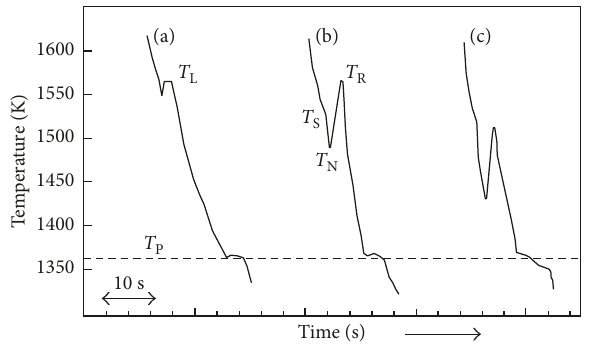
Figure 2: Measured cooling curves of three Cu-15 wt.% Fe samples: (a) ∆ T 35K; (b) ∆ T 75K; and (c) ∆ T 141K. T P , T N , T S , and T R (cid:31) (cid:31) (cid:31) are, respectively, peritectic, solid nucleation, liquid separation, and maximum recalescence temperatures.